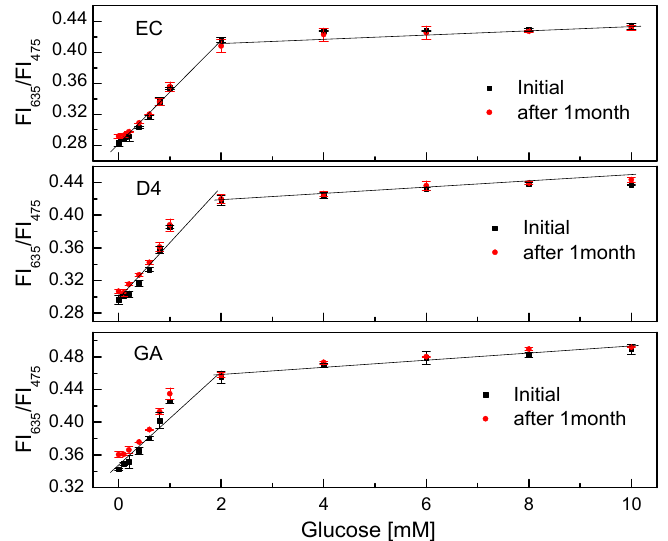
Figure 10. Lifetime of GOD = PS@C6^PtP membranes with different supporting materials (EC, D4, and GA) at different glucose concentrations.